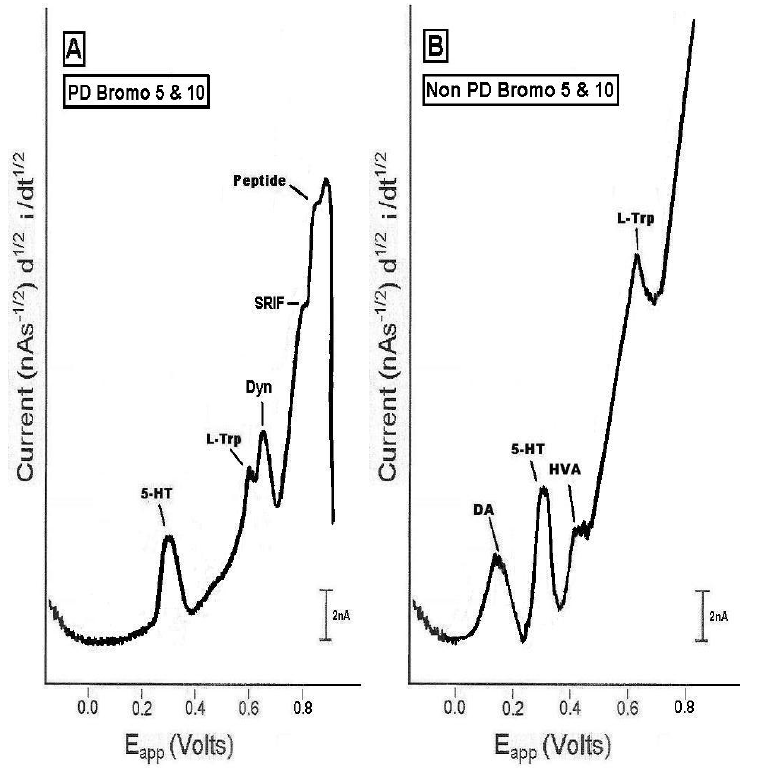
Figure 4. Representative NMI neurochemical signature profiles in dorsal striatum of (left) the PD and (right) the non-PD animal, after administration of the dopamine agonist, bromocriptine (5 mg/kg ip followed by 10 mg/kg ip) (high dose) in vivo , on line and in real time. Neurochemical profiles are drawn from original